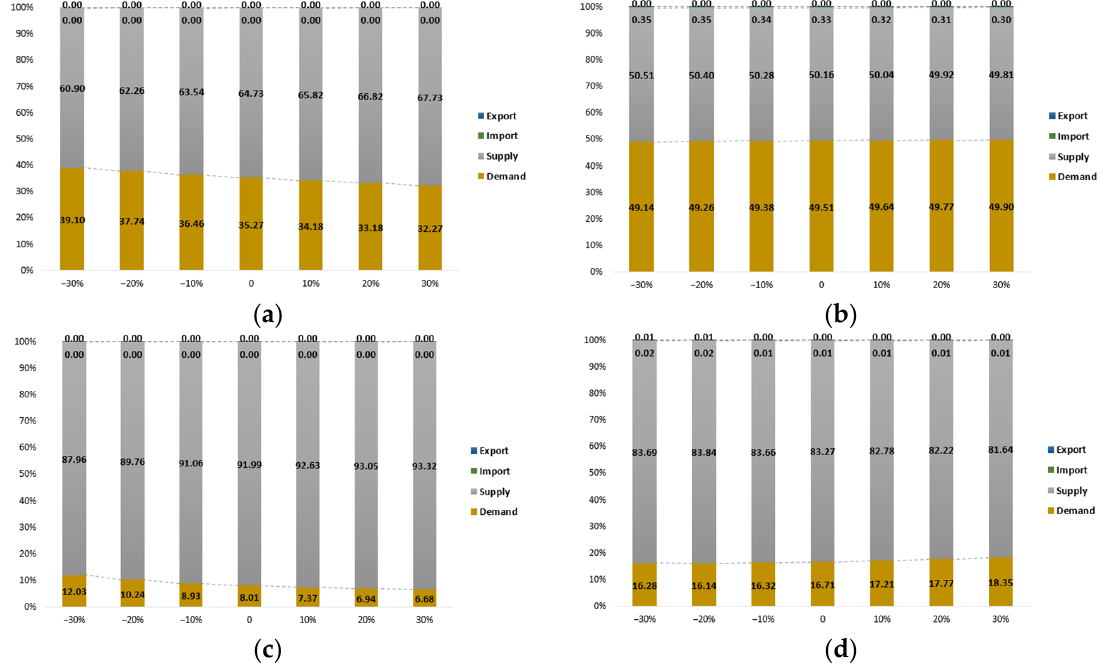
Figure 4. Numerical simulation results of radish. ( a ) Spring radish; ( b ) Highland radish; ( c ) Fall radish; ( d ) Winter radish.